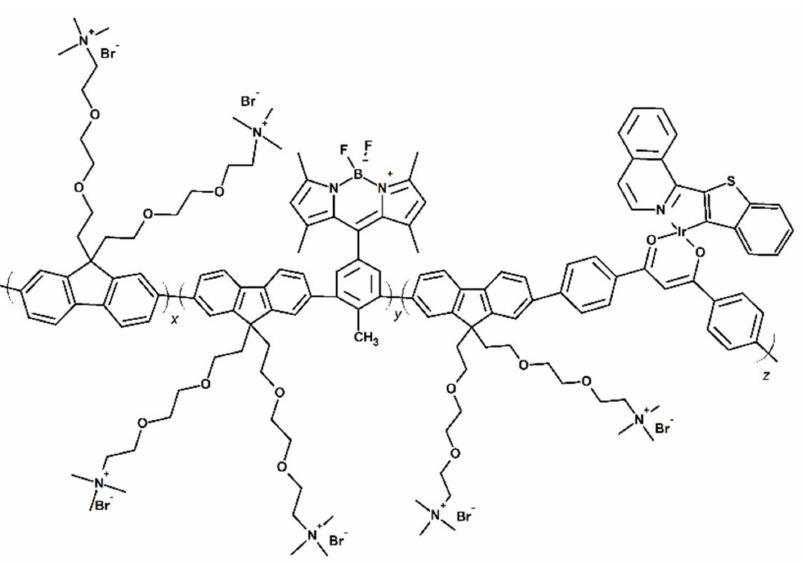
Figure 6. Schematic representation of the polyfluorene-based conjugated polymer with covalently attached Ir (III) complex and BODPIY units (investigated in